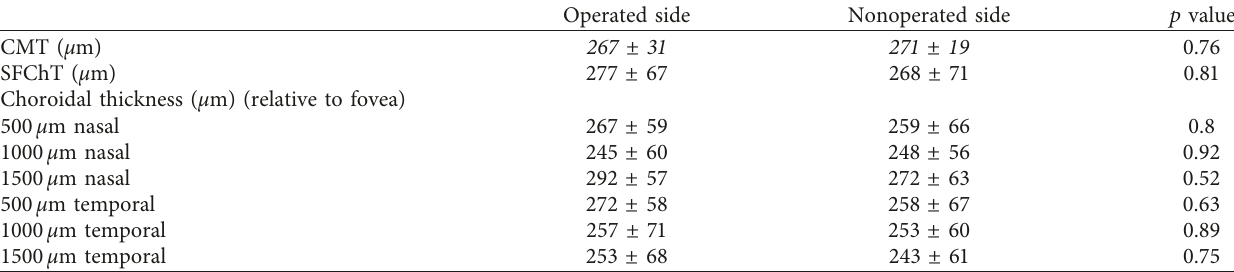
Table 3: CMT and SFChT comparison between the operated and nonoperated sides.